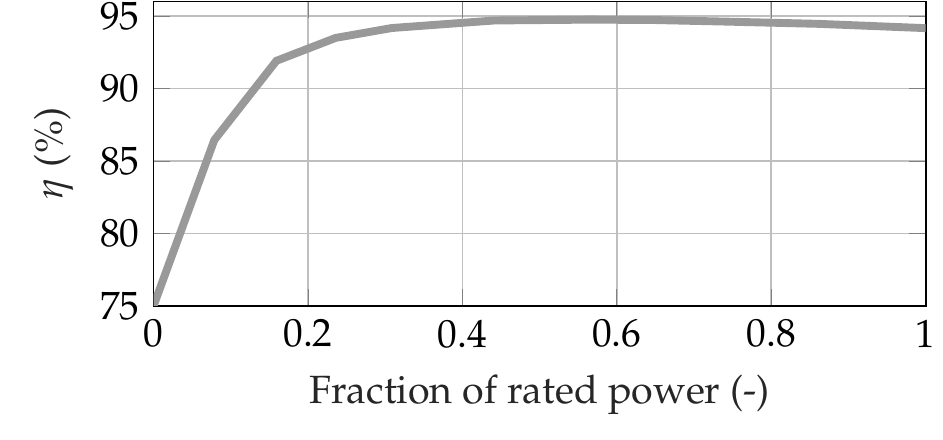
Figure 8. Efficiency of the DC/DC converter.